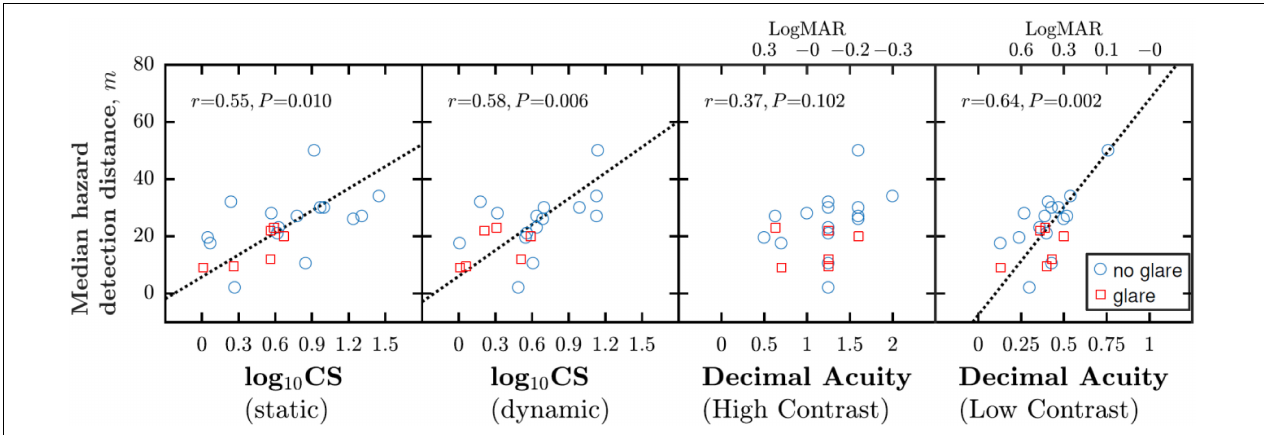
FIGURE 2 | Correlations between night driving performance, as measured by MHDD, and various measures of CS (measured within the simulator) and VA (measured outside the simulator). Each marker indicates data from a single participant, with measurements made either with glare (red squares) or without glare (blue circles). Dashed lines show best fitting geometric mean (“error in both axes”) regression slopes.